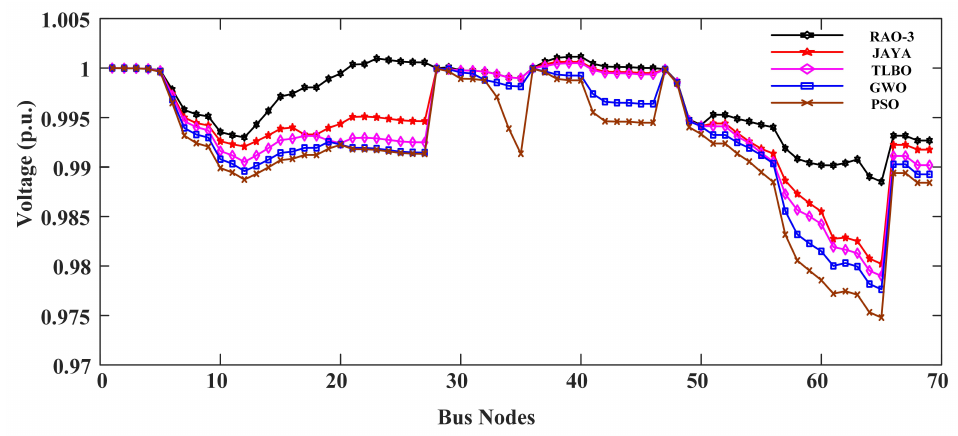
Figure 12. Voltage curve.